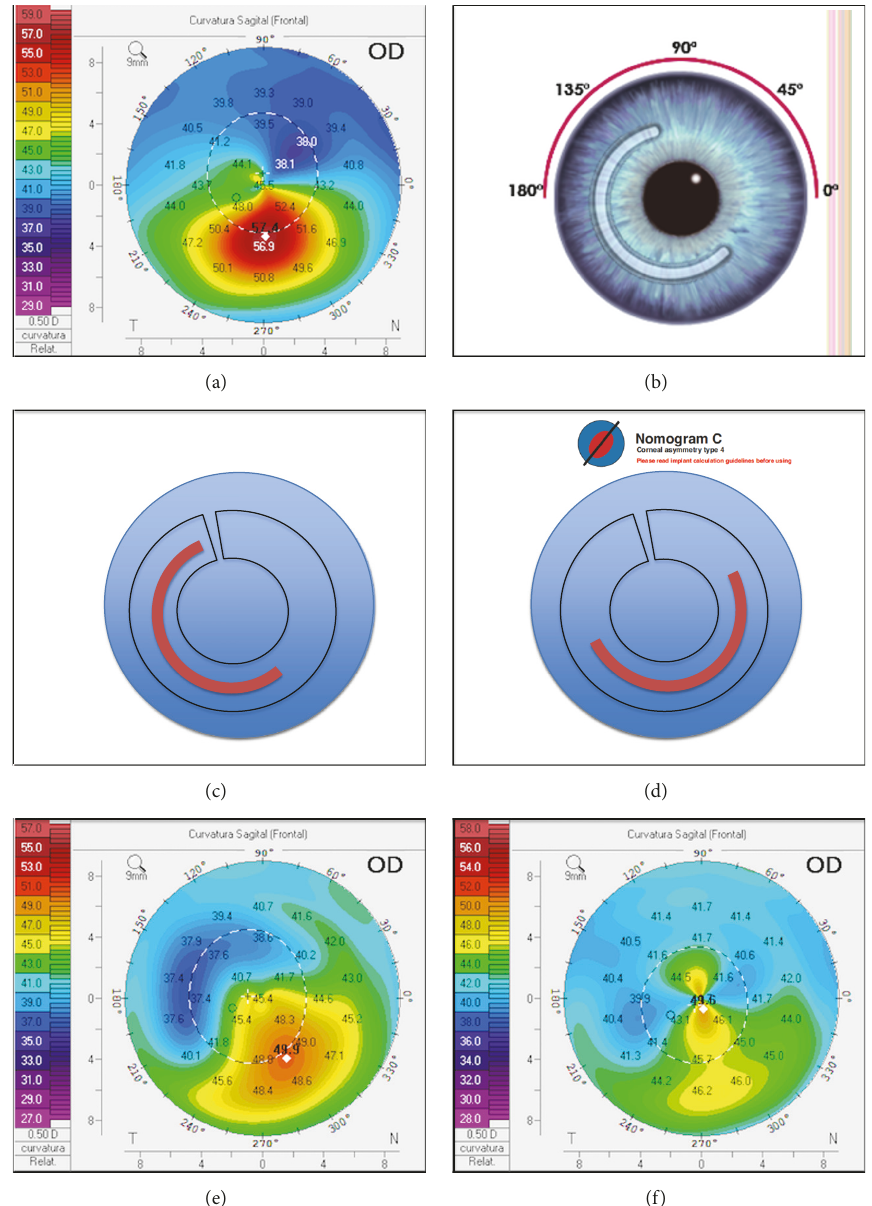
Figure 2: (a) Topography pretreatment. (b) Ferrara nomogram. (c) First intrastromal ring position. (d) KeraRing nomogram position. (e) One-month postimplantation ring position. (f) One-year postmodification ring